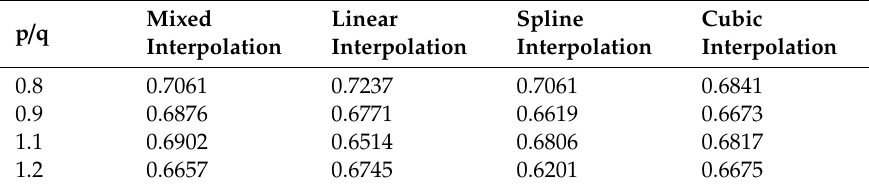
Table 3. Detection results of Hou et al. [15] under di ff erent interpolation methods. p / q